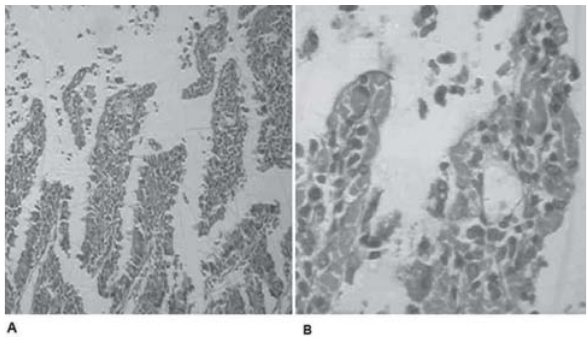
Fig. 5 - Fotomicrografia do grau 3 da classificação de Chiu et al.